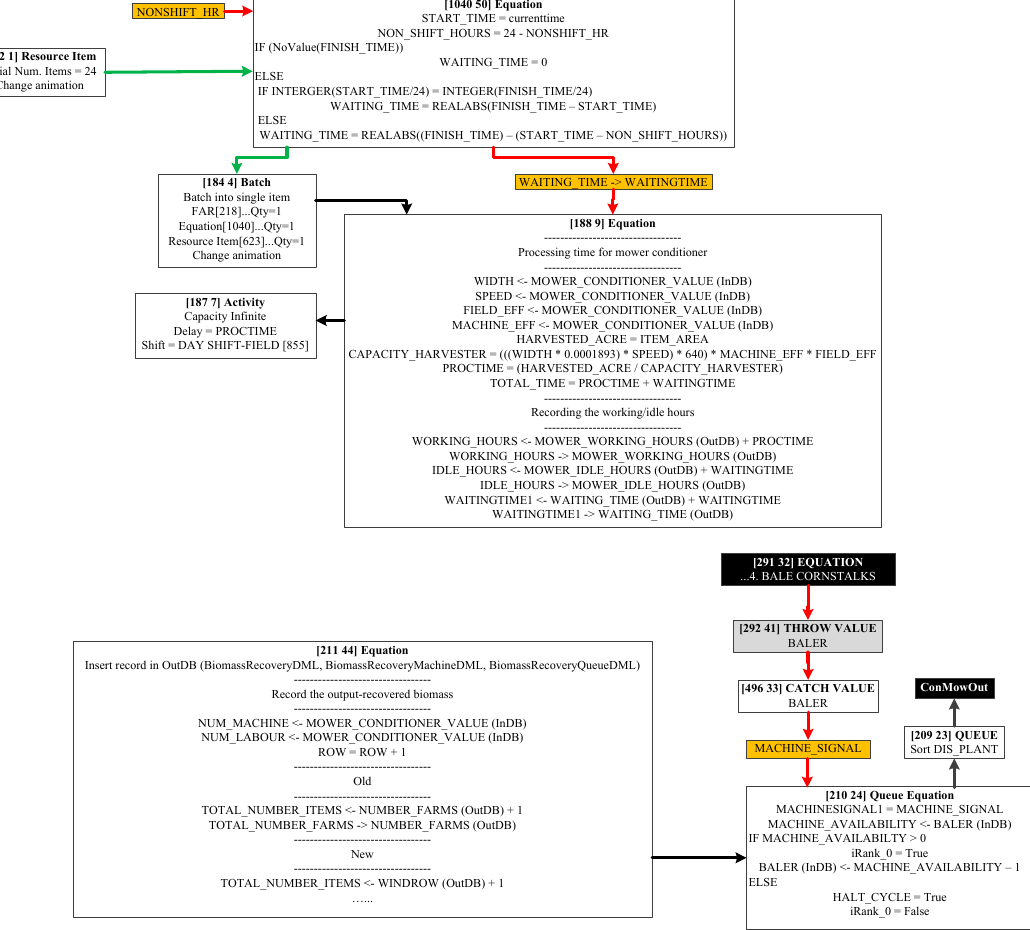
Figure A1. Section of the original Shred/Windrow module.